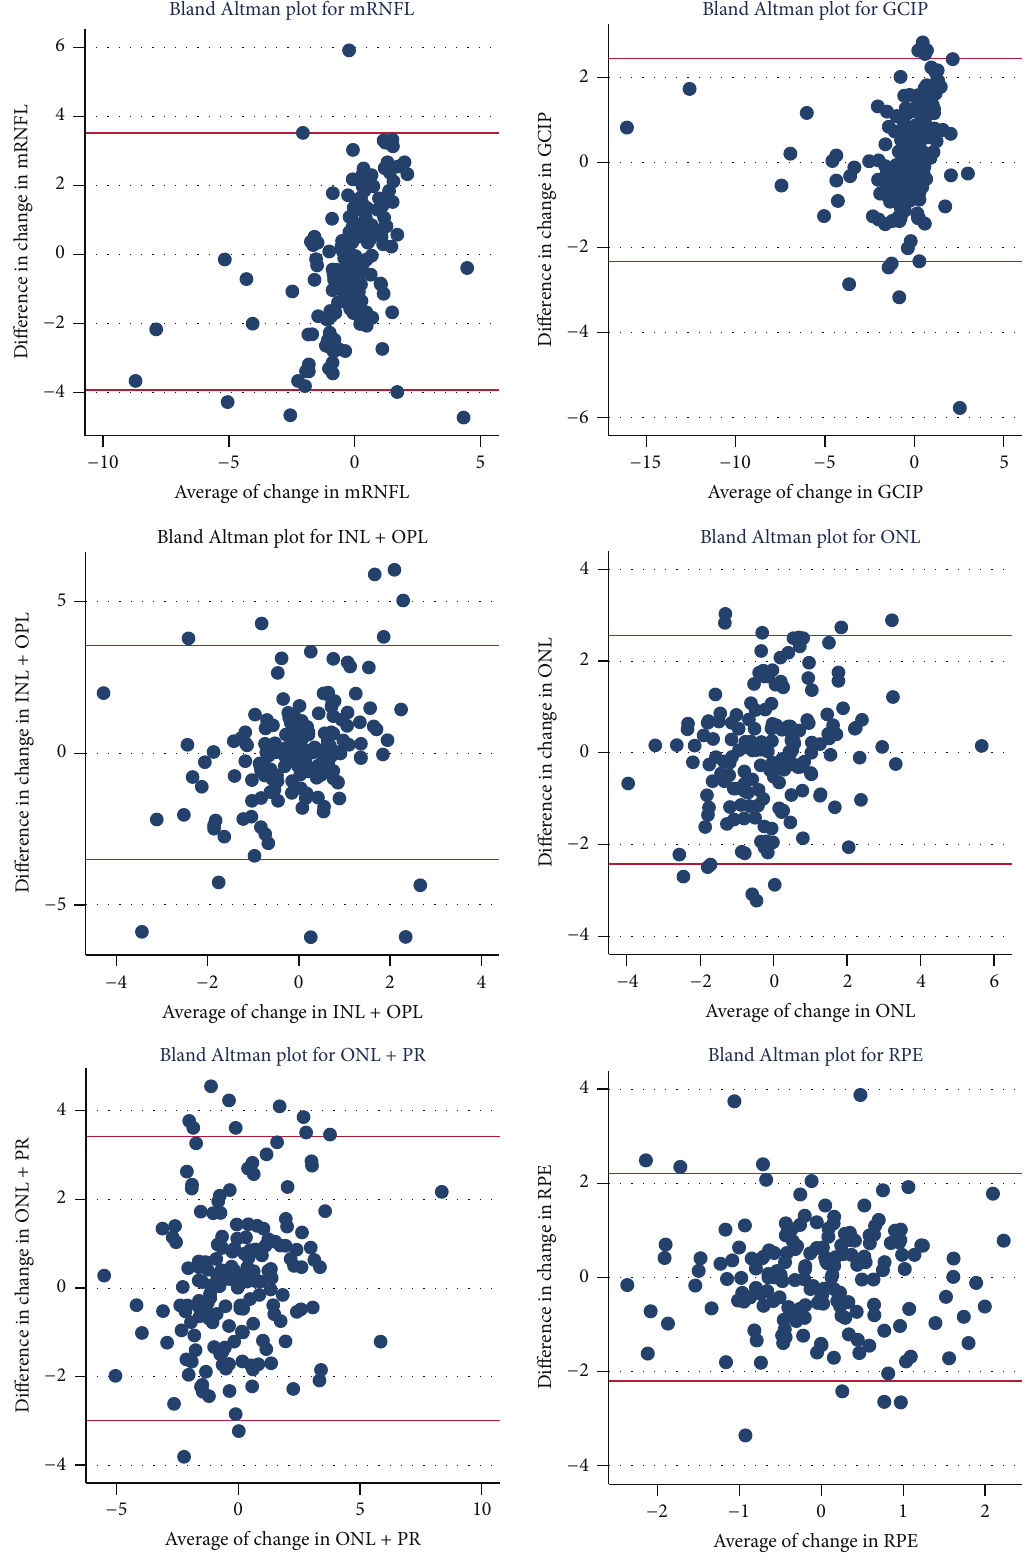
Figure 4: Bland-Altman plots of longitudinal comparison of change in retinal layer thicknesses. Scatter plots of the difference versus the average of change in the retinal layer measurements from two scanners. The horizontal lines represent the upper and lower limits of agreement (LOA). The majority of plotted points fall within the LOA as expected in all